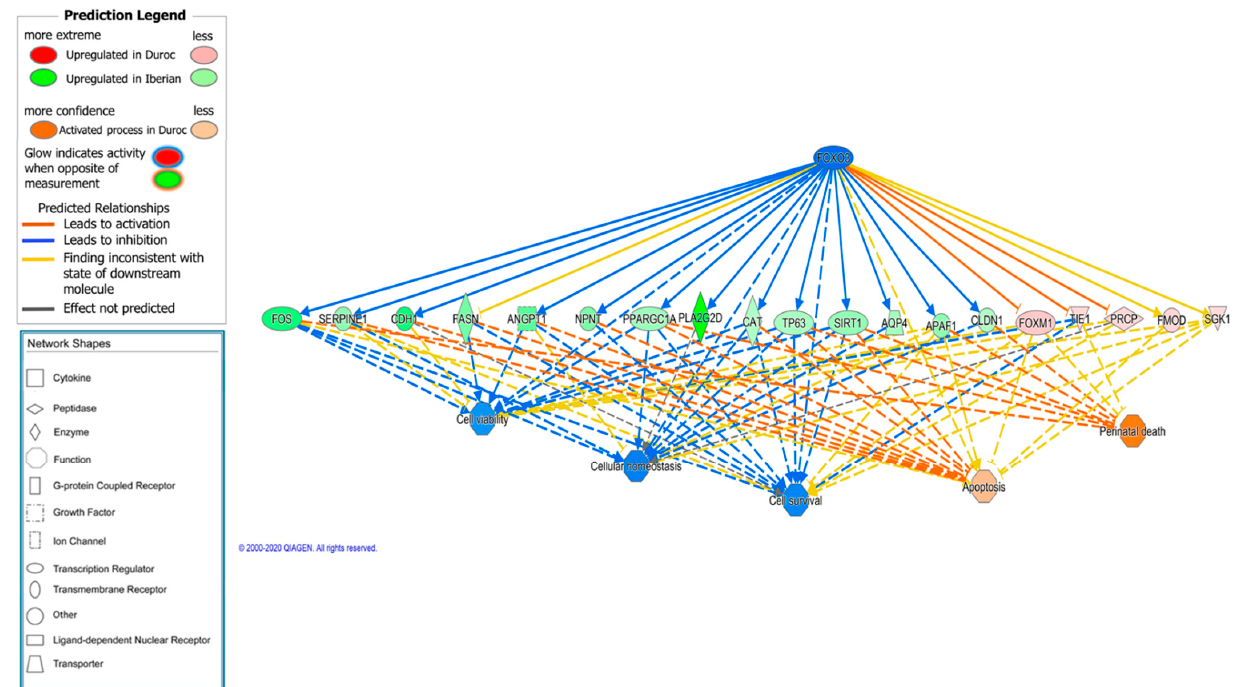
Figure 7. Causal network of FOXO3 regulator activated in Iberian pigs (z-score = − 2.982; p -value 3.7 × 10 − 5